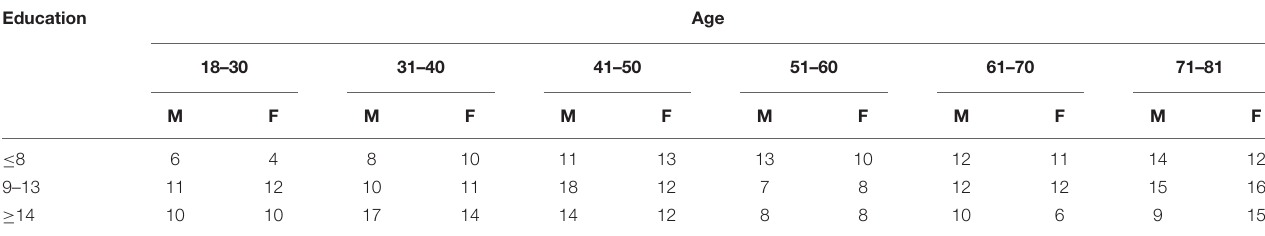
TABLE 1 | Number of participants as a function of age, education (years of schooling) and gender (M-Male and F-Female).